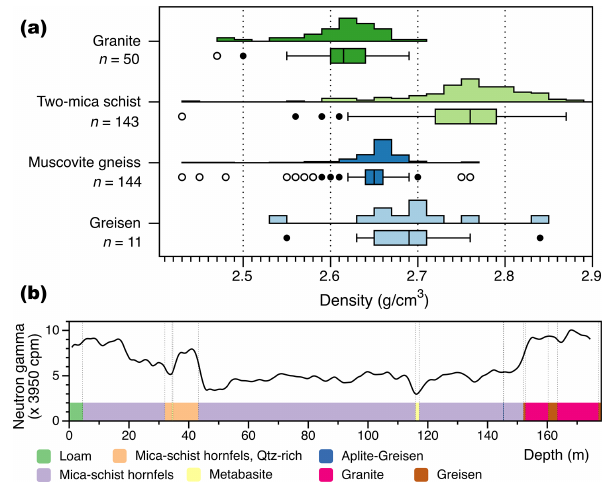
Figure 2. Petrophysical data for the rock types of this study. (a) Density based on drill-core samples from the Ehrenfriedersdorf- Geyer area (data source: Klemps and Lindner, 1985); (b) Downhole neutron gamma log data from drill hole Ehf 8/76 (see Fig. 1 for location). Data source: Sächsisches Landesamt für Umwelt, Land- wirtschaft und